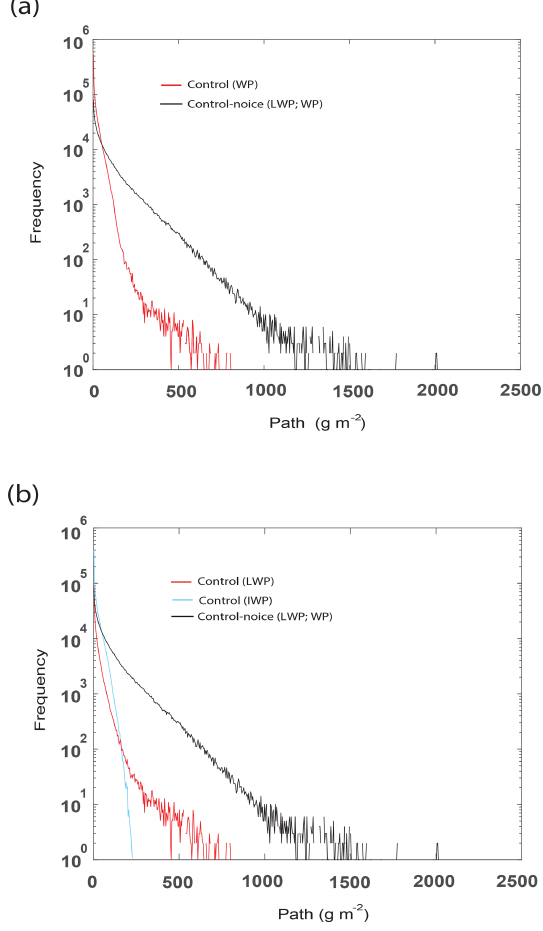
Figure 6. Vertical distributions of (a) the time- and domain- averaged updraft mass fluxes for the control and control-noice runs and (b) the average cloud ice number concentration (CINC) over grid points and time steps with non-zero CINC (for the whole do- main and simulation period in the control run).